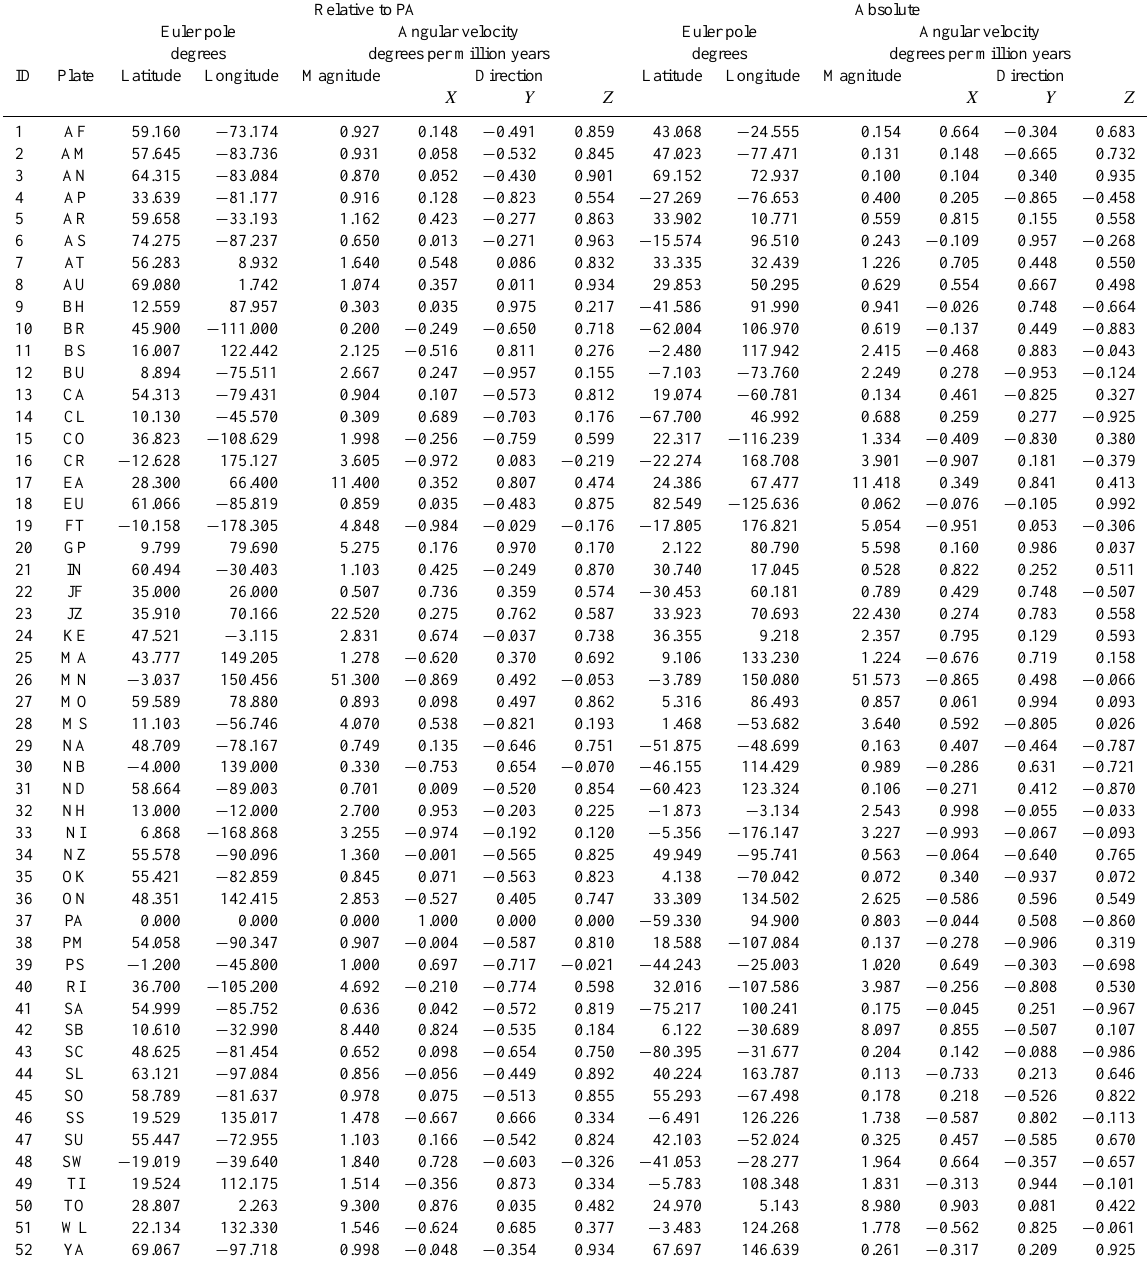
Table 1. Euler pole and angular velocity estimates; based on Pacific Plate absolute rotation from Morgan and Morgan (2007). Relative to PA Absolute Euler pole Angular velocity Euler pole Angular velocity degrees degrees per million years degrees degrees per million years ID Plate Latitude Longitude Magnitude Direction Latitude Longitude Magnitude Direction X Y Z X